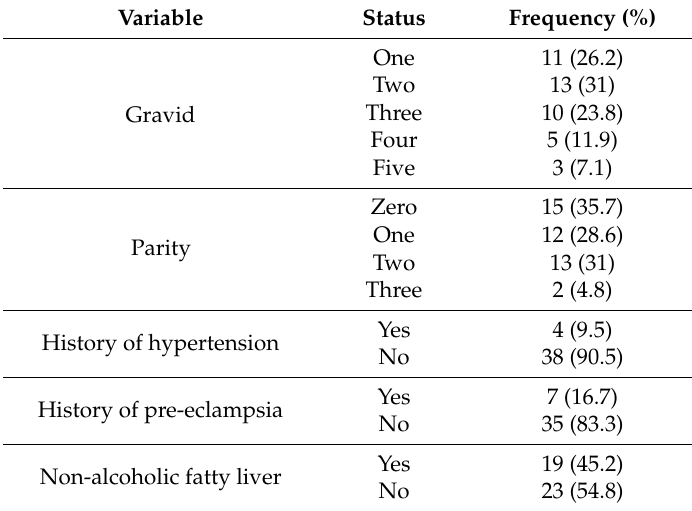
Table 2. Basic characteristics of the population in terms of percentage and frequency.